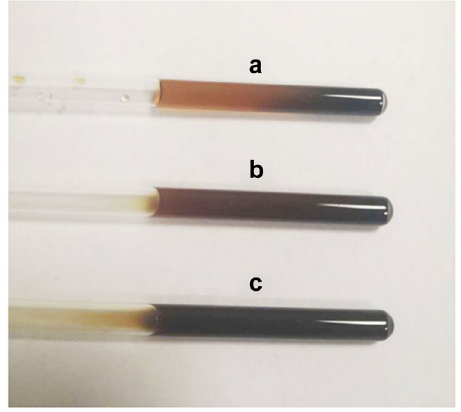
Figure 1: Dissolving state of tobacco stem cell walls in di ff erent solvents: ( a ) DMSO - d 6 , ( b ) DMSO - d 6 /pyridine - d 5 , ( c ) DMSO - d 6 / HMPA - d 18